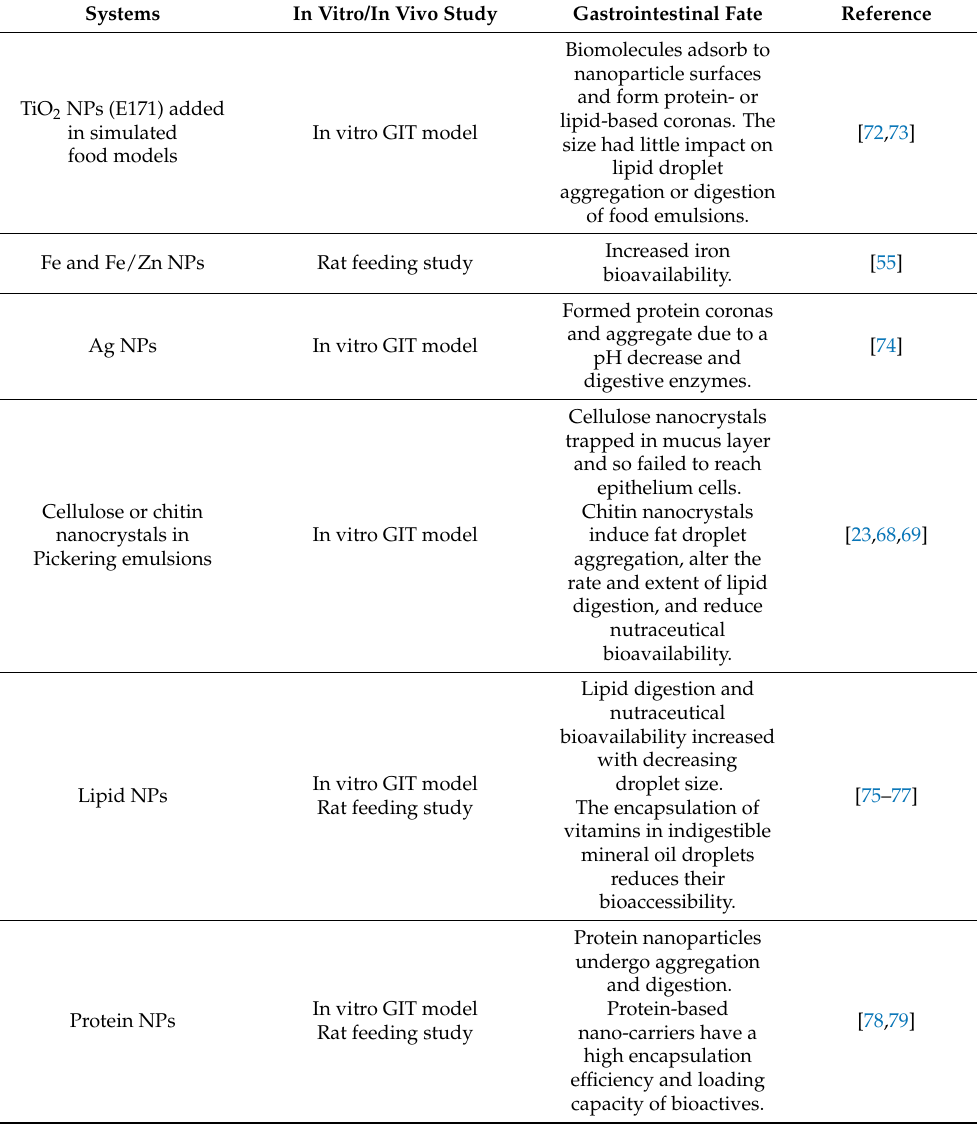
Table 1. Selected examples of studies on the gastrointestinal fate of different kinds of inorganic and organic nanoparticles